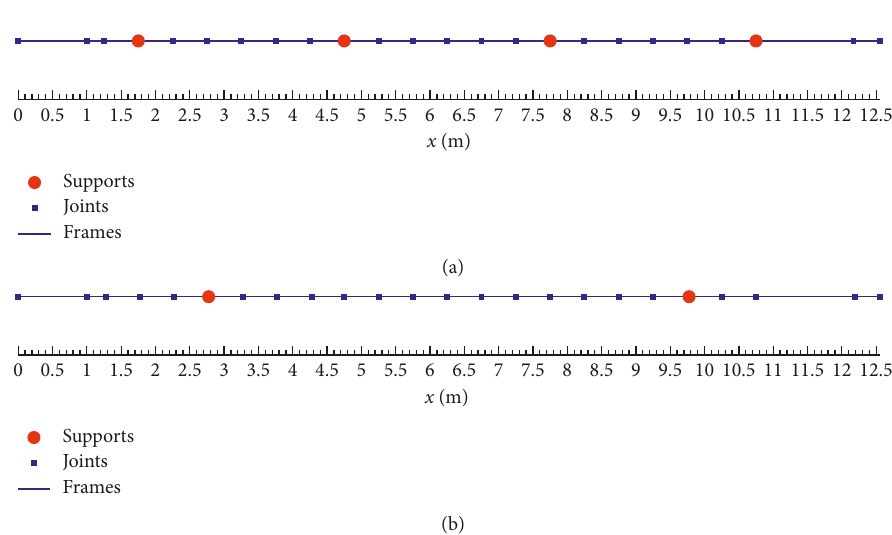
Figure 4: Schematic representation of the deck FE models in the two design alternatives. (a) Alternative 1: D1. (b) Alternative 2: